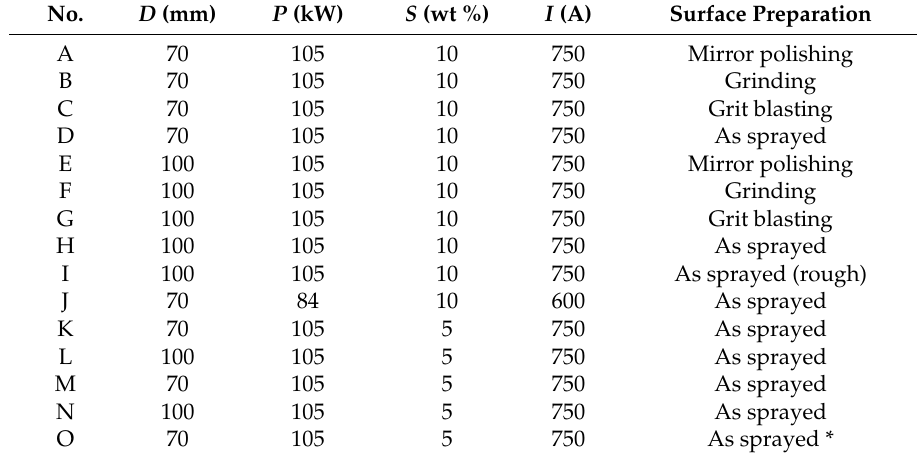
Table 1. Spray parameters used for YSZ top